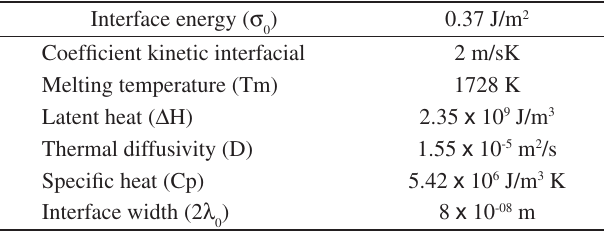
Table 4. Properties material (Ni) 6 .